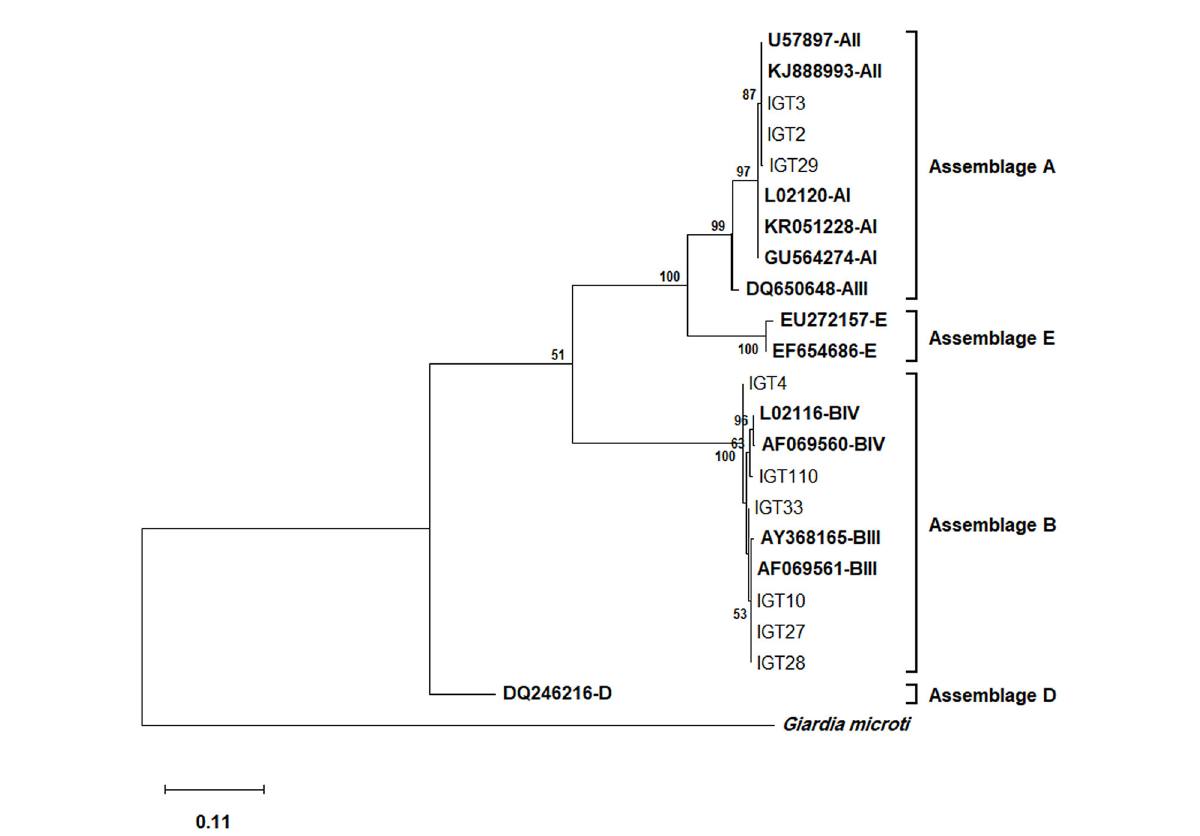
FIGURE1 The phylogenetic analysis of the tpi gene nucleotide sequences of Giardia duodenalis using the Maximum Likelihood (ML) method and Tamura 3-parameter model (38) (T92 + G + I). The analysis involved 23 nucleotide sequences: Nine representative nucleotide sequences of tpi retrieved from this study (LC183913–LC183966) compared with 13 reference sequences of known assemblages from Genbank (indicated in bold) with Giardia microti as an outgroup. The percentage of trees in which the associated taxa clustered together (achieved from 1000 replicates) is shown next to the branches, only bootstrap values > 50% are demonstrated. A discrete Gamma distribution was used to model evolutionary rate differences among sites [5 categories ( + G , parameter = 9.6789)]. The rate variation model allowed for some sites to be evolutionarily invariable [( + I ), 27.96% sites]. The scale bar represents substitutions per nucleotide. The final dataset contained 456 positions. Evolutionary analyses were conducted in MEGA X